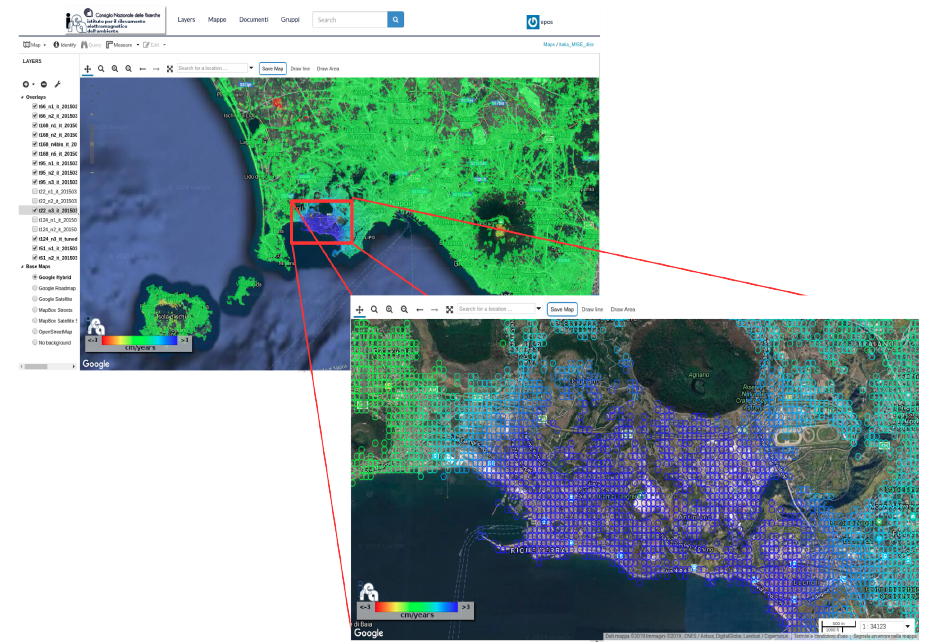
Figure 14. Zoomed view of the Sentinel-1 SBAS-DInSAR mean deformation velocity map relevant to the Campi Flegrei caldera (Italy): each polygon represents an area on the ground of about 90 m × 90